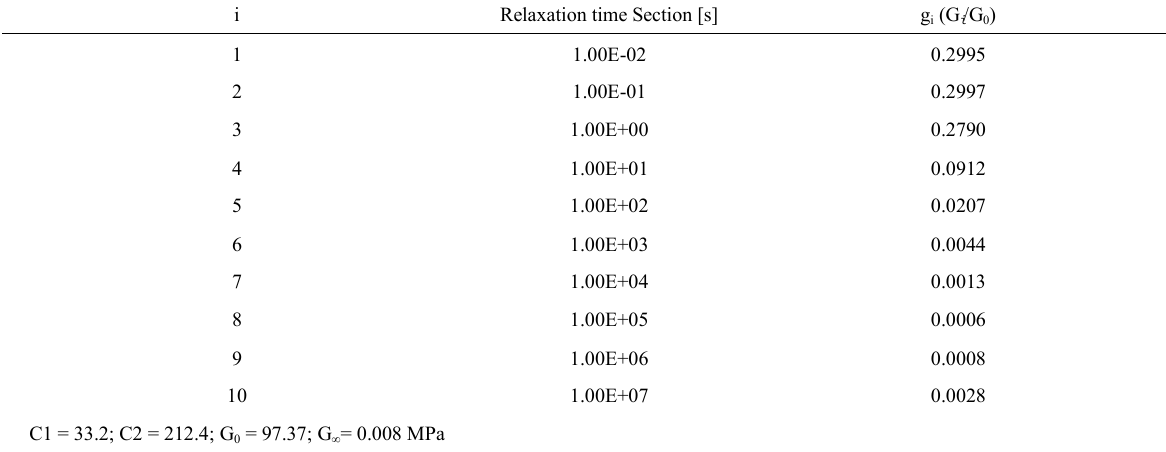
Table 1: Model parameters for the evaluation shear relaxation modulus G(t,T) for Saflex Clear RB (T ref = 20